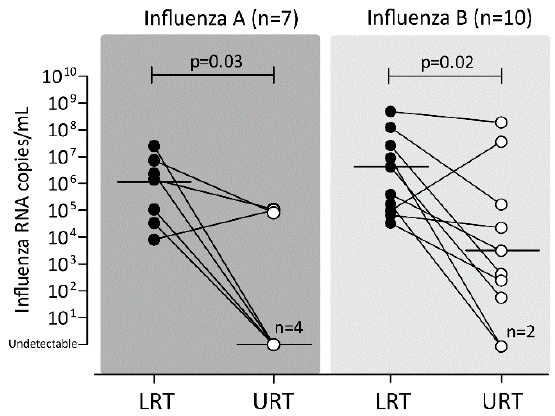
Figure 4. Comparison of viral loads detected in paired URT and LRT samples in patients diagnosed with influenza A and B. Upper respiratory tract, URT; lower respiratory tract; LRT.